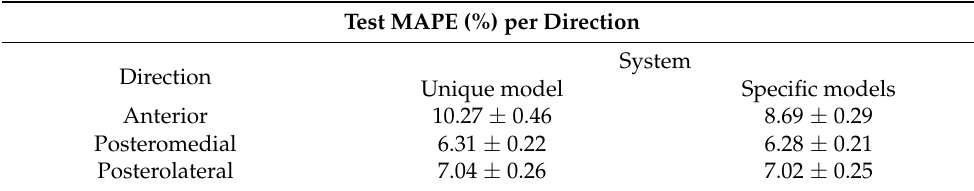
Figure 11. Results from a unique system and specific systems. Table 7 indicates the testing MAPE obtained for each direction depending on the approach. We could observe that the error performance of each direction could be reduced, being significant for the anterior direction. Table 7. Results for both strategies: unique system and specific systems for each direction.